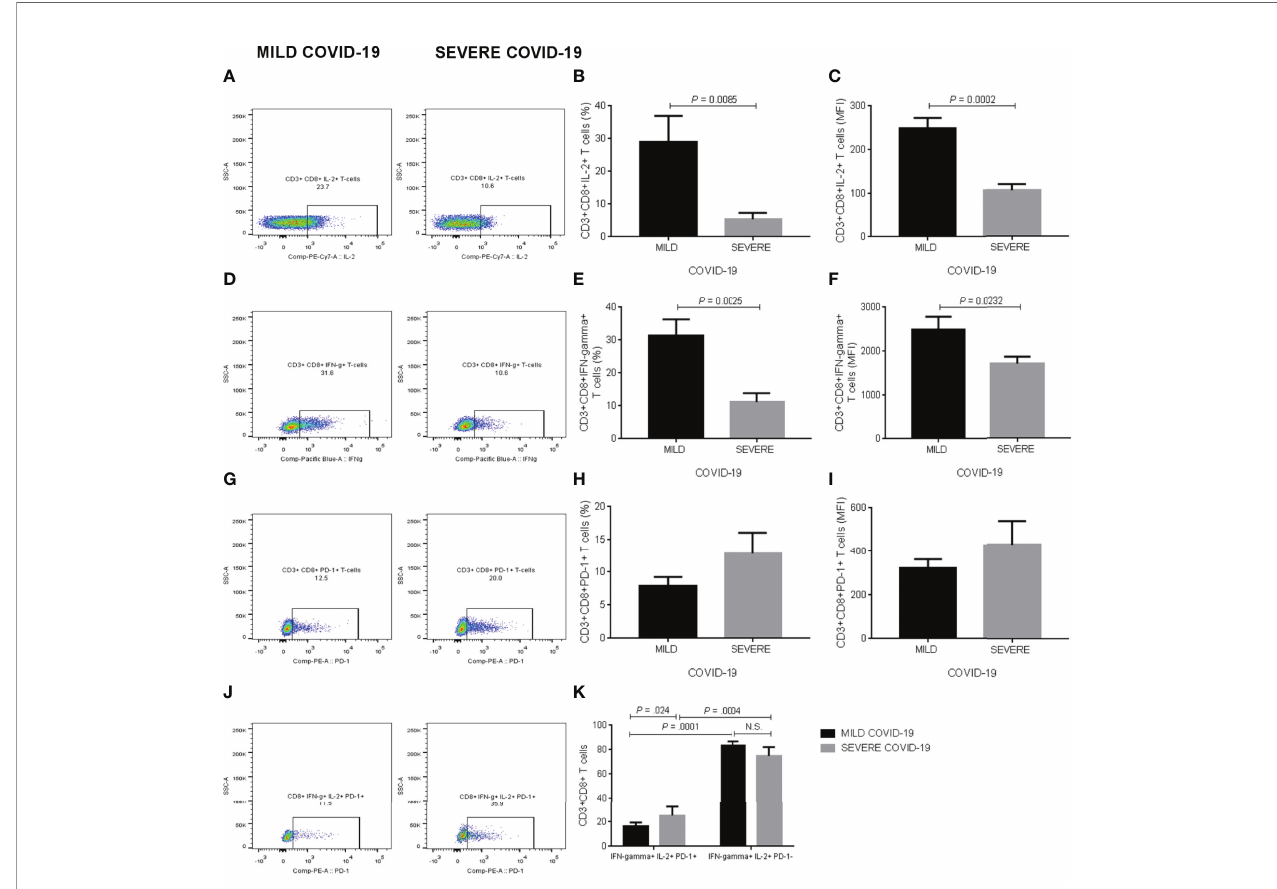
FIGURE 3 | IL-2, IFN-gamma, and PD-1 expression in CD3+CD8+ T cells in response to polyclonal stimuli in vitro . (A) Representative dot-plots illustrating the comparison of CD3+CD8+ T cells expressing IL-2 in blood samples treated with polyclonal stimuli from participants who developed mild or severe COVID-19 during the follow-up. (B) Percentage of CD3+CD8+ T cells expressing IL-2. (C) Mean fl uorescence intensity of IL-2 in CD3+CD8+ T cells. (D) Representative dot-plots exemplifying the contrast of CD3+CD8+ T cells expressing IFN-gamma in whole blood samples exposed to polyclonal molecules from participants who experienced mild or severe COVID-19 throughout the follow-up. (E) Percentage of CD3+CD8+ T cells expressing IFN-gamma. (F) Mean fl uorescence intensity of IFN-gamma in CD3+CD8+ T cells. (G) Representative dot-plots illustrating the comparison of CD3+CD8+ T cells expressing PD-1 in blood samples treated with polyclonal stimuli from participants who developed mild or severe COVID-19 during the follow-up. (H) Percentage of CD3+CD8+ T cells expressing PD-1. (I) Mean fl uorescence intensity of PD-1 in CD3+CD8+ T cells. (J) Representative dot-plots exemplifying the contrast of CD3+CD8+ T cells simultaneously expressing IL-2, IFN-gamma, and PD-1 in whole blood samples exposed to polyclonal molecules from participants who experienced mild or severe COVID-19 throughout the follow-up. (K) Percentage of CD3+CD8+ T cells producing both IL-2 and IFN-gamma depending on PD-1 expression. Prior to infection, we obtained whole blood samples from all participants enrolled in the study and cultured them with polyclonal stimuli, including anti-CD3, anti-CD28, poly I:C, and SARS-CoV-2 recombinant spike S1 protein for two hours. We then acquired CD3+CD8+ T cells on a BD FACS Canto II Flow Cytometer, acquiring 10,000 events per test in triplicate and storing data until a participant got SARS-CoV-2 infection. Upon infection and depending on the clinical course of the disease, we analyzed fl ow cytometry data as part of the mild or severe COVID-19 groups. Black bars represent the mild COVID-19 group. Gray bars represent the severe COVID-19 group. We expressed data as mean ± standard deviation. We compared data using the unpaired Student ’ s T-test or two-way ANOVA and considered differences signi fi cant when P < 0.05. IL-2, interleukin-2; IFN-gamma, interferon-gamma; PD-1, programmed cell death protein 1; MFI, mean fl uorescence intensity; COVID-19, coronavirus disease 2019; SARS-CoV-2, severe acute respiratory syndrome coronavirus type